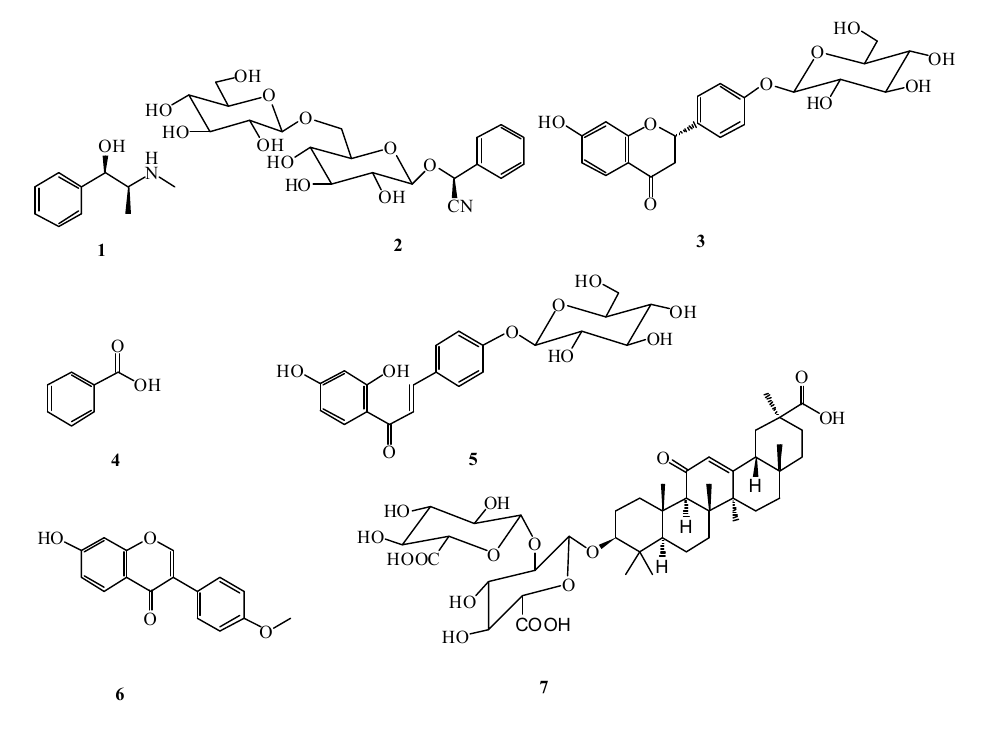
Figure 1. The structures of the reference compounds: ephedrine ( 1 ), amygdalin ( 2 ), liquiritin ( 3 ), benzoic acid ( 4 ), isoliquiritin ( 5 ), formononetin ( 6 ) and glycyrrhizic acid ( 7